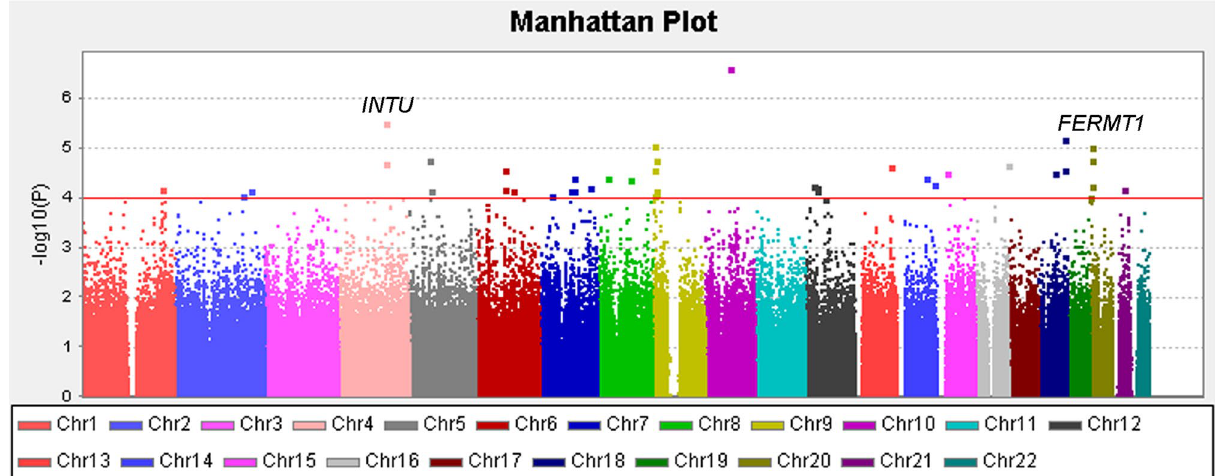
Figure 2. Manhattan plot of endometriosis. Results of genome-wide association analysis (− log 10 P ) presented in chromosomal order for 620,465 SNPs tested for association in 126 endometriosis and 96 non-endometriosis control. The x axis shows each of the SNPs used in the discovery phase. The y axis shows the − log 10 P value of the trend test. Signals in inturned planar cell polarity protein ( INTU ) and fermitin family member 1 ( FERMT1 ) loci are also presented. SNP single nucleotide polymorphism.